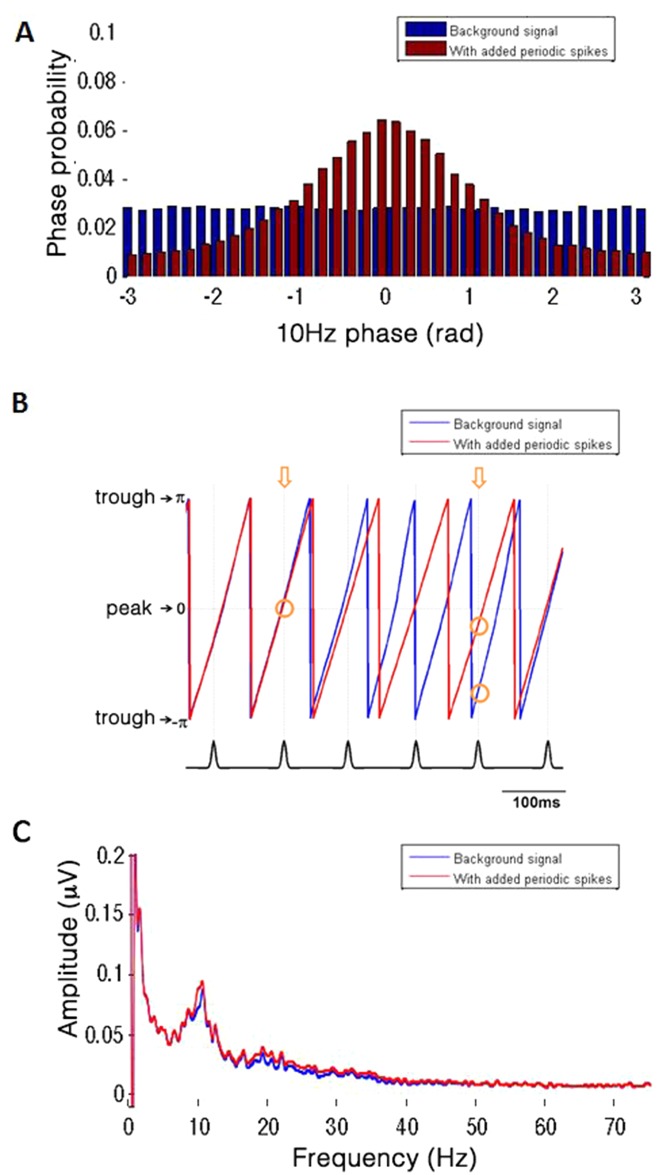
Phase-shift of the background EEG signal after the addition of periodic potentials.The signal was generated by adding a Gaussian spike train with 100-ms mean inter-peak interval, 15-ms width and amplitude of 1.5 STDs to the background EEG trace. A, Distribution of 10Hz phase values at the time points where Gaussian peaks occurred. Blue: 10Hz phase extracted from the background EEG signal before adding the Gaussians train; red: phase extracted from the compound signal. It can be seen that while the spikes were inserted at random points of the 10Hz cycle of the background signal, the same time points show a prominent phase-concentration around the cycle peak (phase 0) once the Gaussians were integrated with the signal. That is, the 10Hz cycle tends to align with the transient periodicity such that a phase-amplitude relation emerges. B, Example of alpha phase change of the EEG background signal in a few consecutive cycles, before and after the introduction of the spike train. Blue trace represents the original signal, red trace represents the compound signal. Note that as the Gaussian peak falls away from the original alpha peak, the new alpha cycle will shift farther in phase (compare the two arrows). C, This rearrangement of the alpha phase can occur without any significant change to the power spectrum.